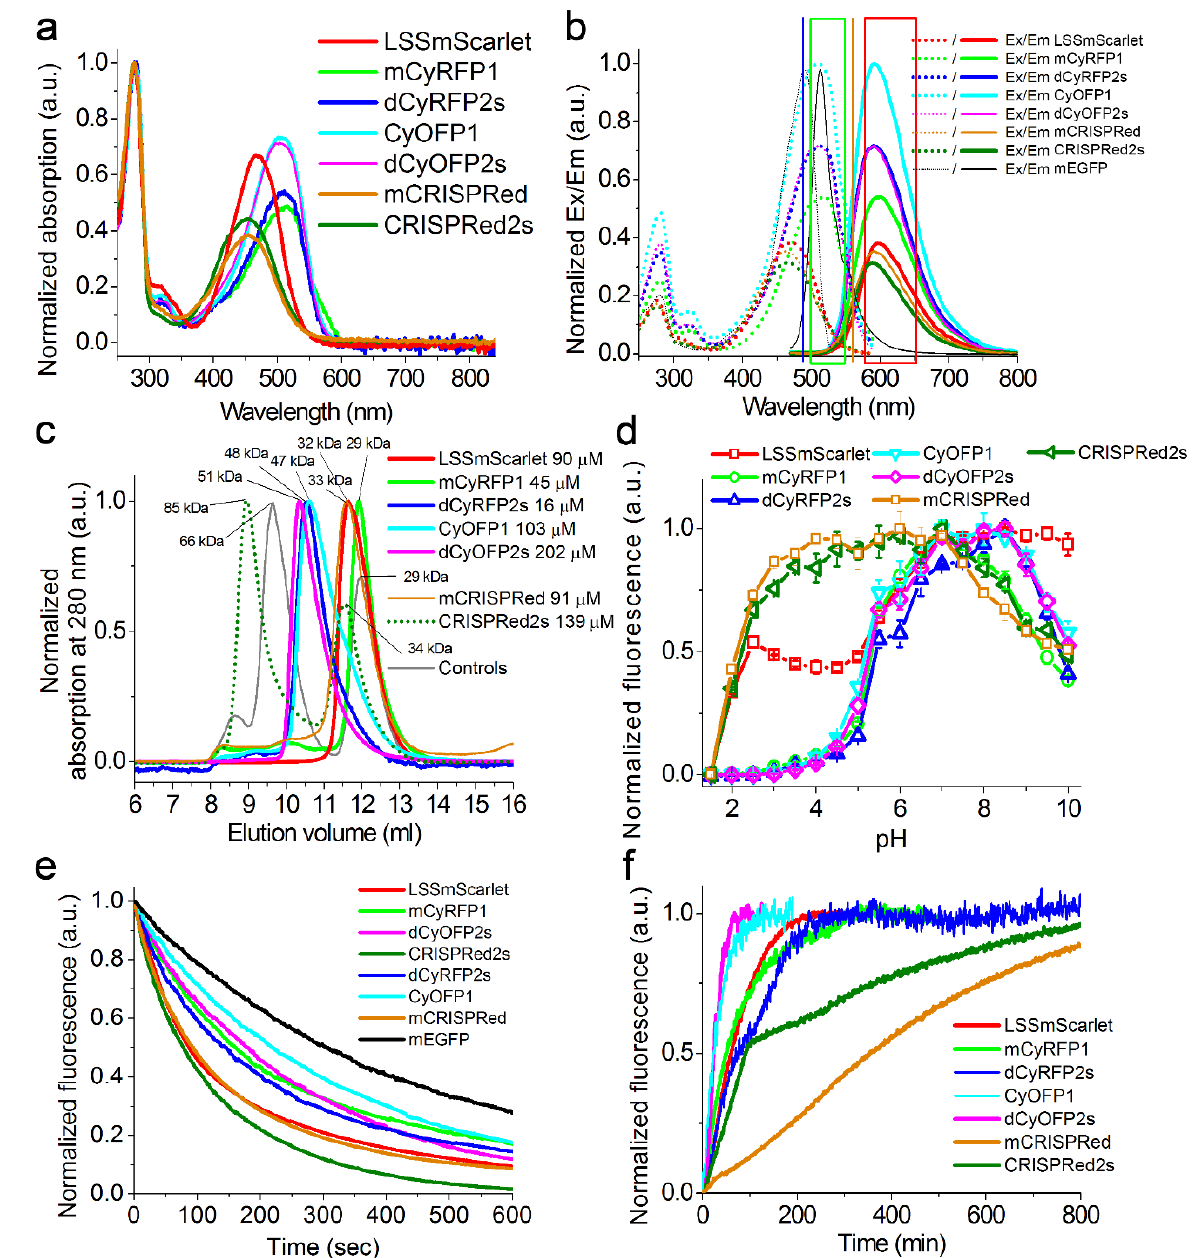
Figure 2. In vitro properties of the purified LSSRFPs proteins. ( a ) Absorption spectra for LSSRFPs proteins in PBS buffer at pH 7.40. ( b ) Excitation and emission spectra for LSSRFPs and mEGFP in PBS buffer at pH 7.40. The 488 and 561 nm excitation laser lines and green/red emission filters used for dual-color imaging are indicated as blue and orange vertical lines and green/red boxes, respectively. ( c ) Fast protein liquid chromatography of LSSRFPs proteins. LSSRFPs were eluted in 20 mM Tris-HCl (pH 7.80) and 200 mM NaCl buffer. The molecular weights of LSSRFPs were calculated from a linear regression of the dependence of logarithm of control molecular weights vs. elution volume (Figure S2). ( d ) Red fluorescence intensity for LSSRFPs as a function of pH. ( e ) Photobleaching of LSSRFPs and mEGFP proteins droplets in oil under continuous wide-field imaging using metal halide lamp (3.78 mW/cm 2 light power before objective lens). ( f ) Maturation of LSSRFPs in PBS buffer at pH 7.40. ( d – f ) Three-six replicates were averaged for analysis. Error bars represent the standard deviation.